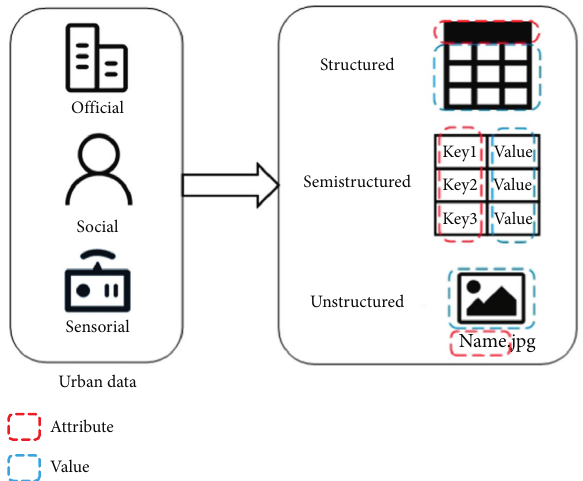
Figure 2: The process of building the attribute-value